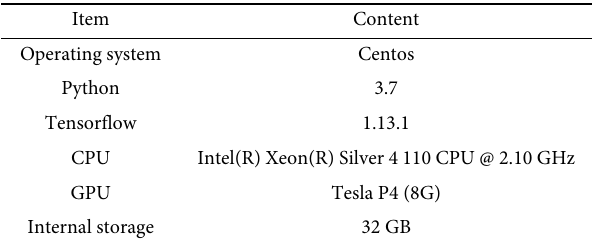
Table 1 Experimental environment.